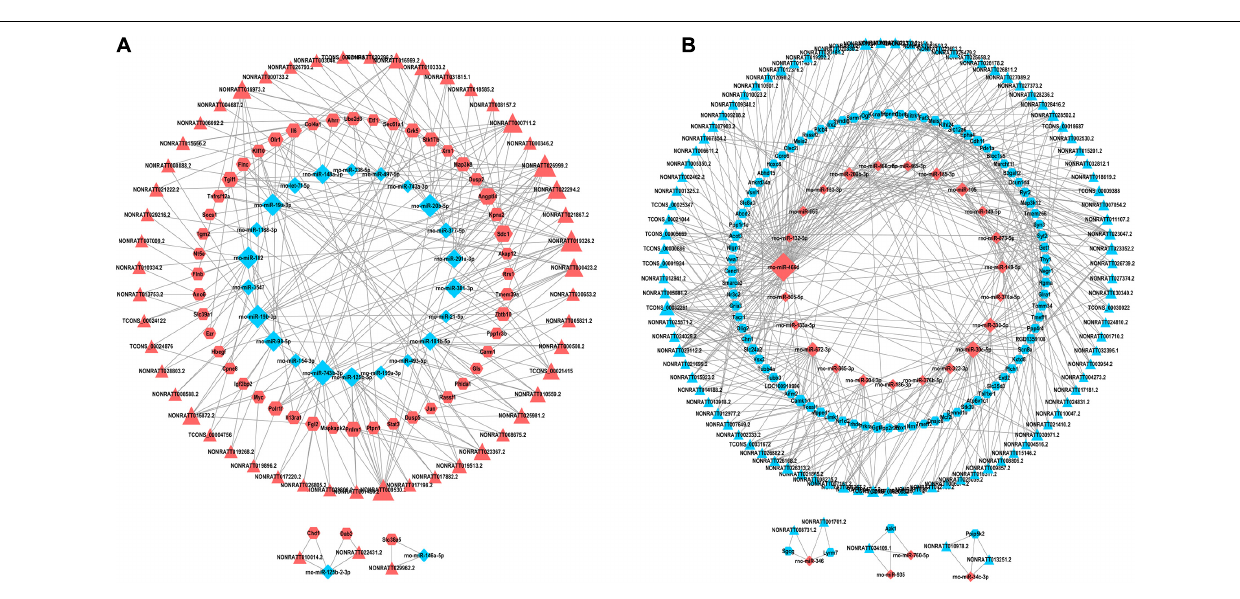
Frontiers in Genetics |